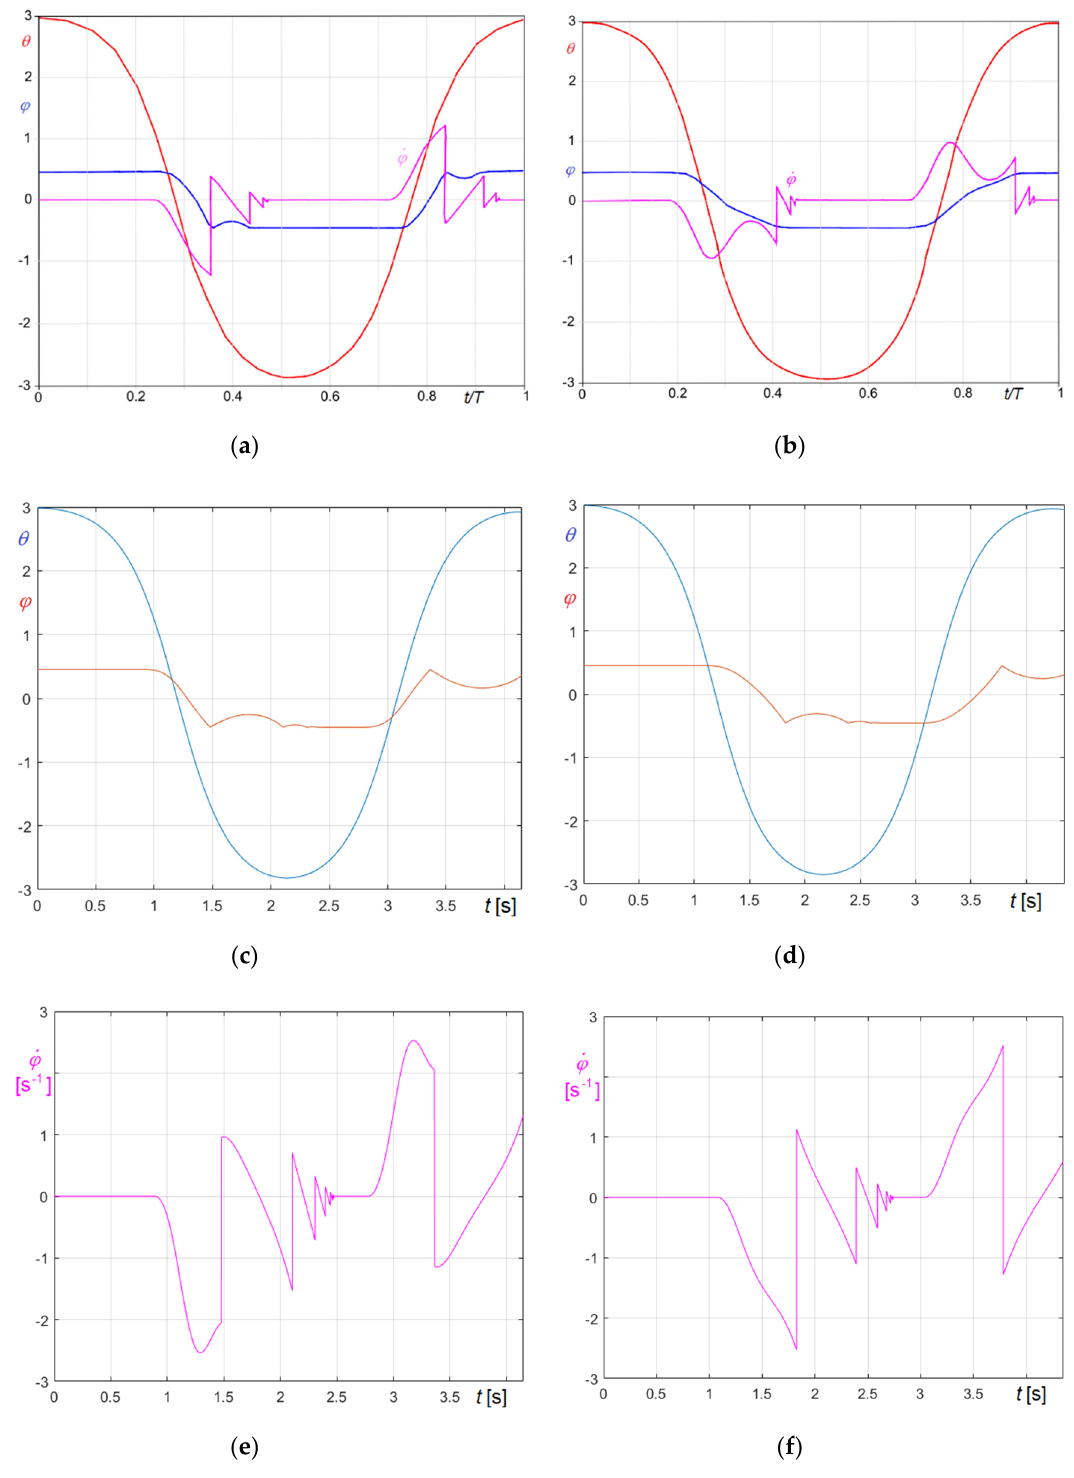
Figure 8. First cycle of bell oscillations and clapper strikes for bells 2 and 3 ringing right: ( a ) Reference results for bell 2 (adapted from [18]); ( b ) Reference results for bell 3 (adapted from [18]); ( c ) θ = θ ( t ) and ϕ = ϕ ( t ) curves obtained with the proposed algorithm for bell 2; ( d ) θ = θ ( t ) and ϕ = ϕ ( t ) curves obtained with the proposed algorithm for bell 3; ( e ) (cid:2030)(cid:4662) = (cid:2030)(cid:4662)(cid:4666)(cid:1872)(cid:4667) curve obtained with the proposed algorithm for bell 2; ( f ) (cid:2030)(cid:4662) = (cid:2030)(cid:4662)(cid:4666)(cid:1872)(cid:4667) curve obtained with the proposed algorithm for bell 3. Finally, to complete that analysis, the case of bell ringing wrong has been studied for bell 2, characterized by (cid:1846) = 4.342 s , and for bell 3, characterized by (cid:1846) = 4.514 s . Results in terms of (cid:2016) =